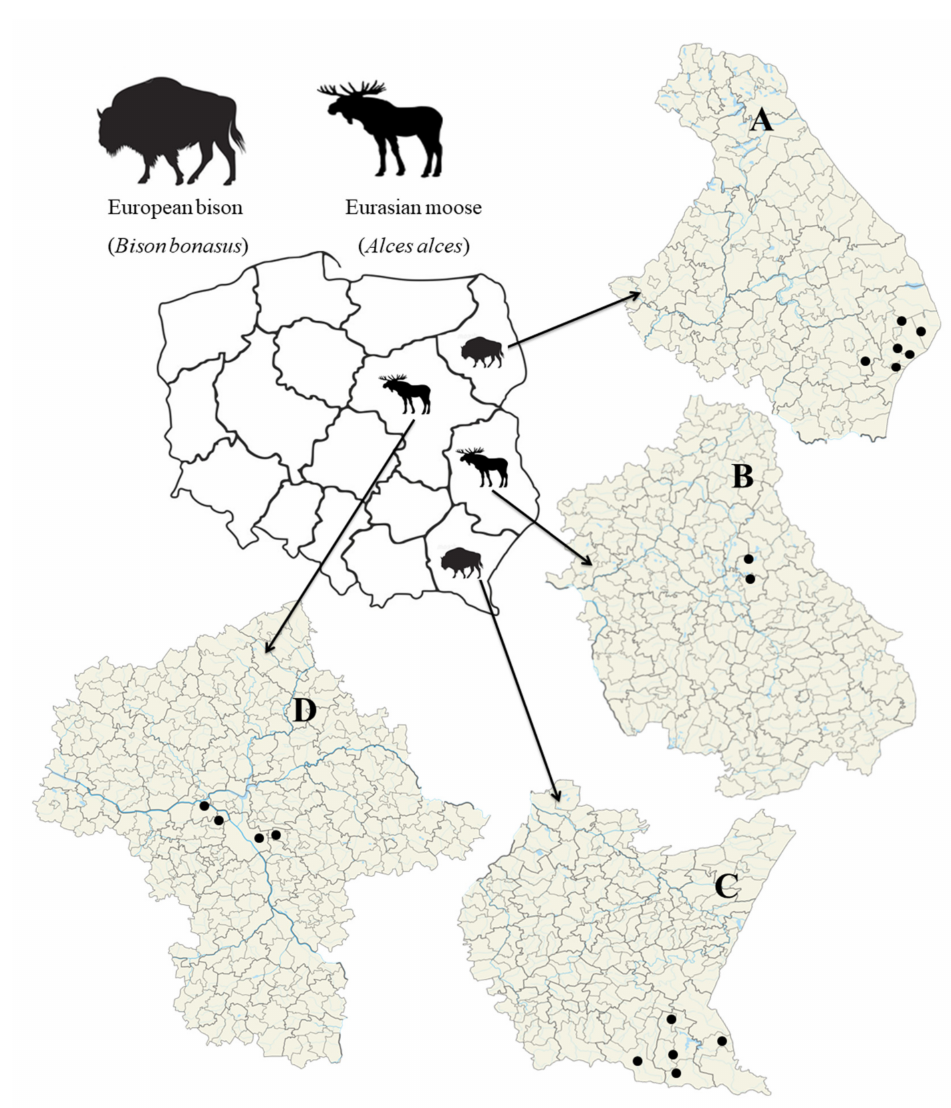
Figure 1. Sampling location in western and central parts of Poland. A—Podlaskie Voivodeship; B—Lublin Voivodeship; C—Subcarpathian Voivodeship; D—Masovian